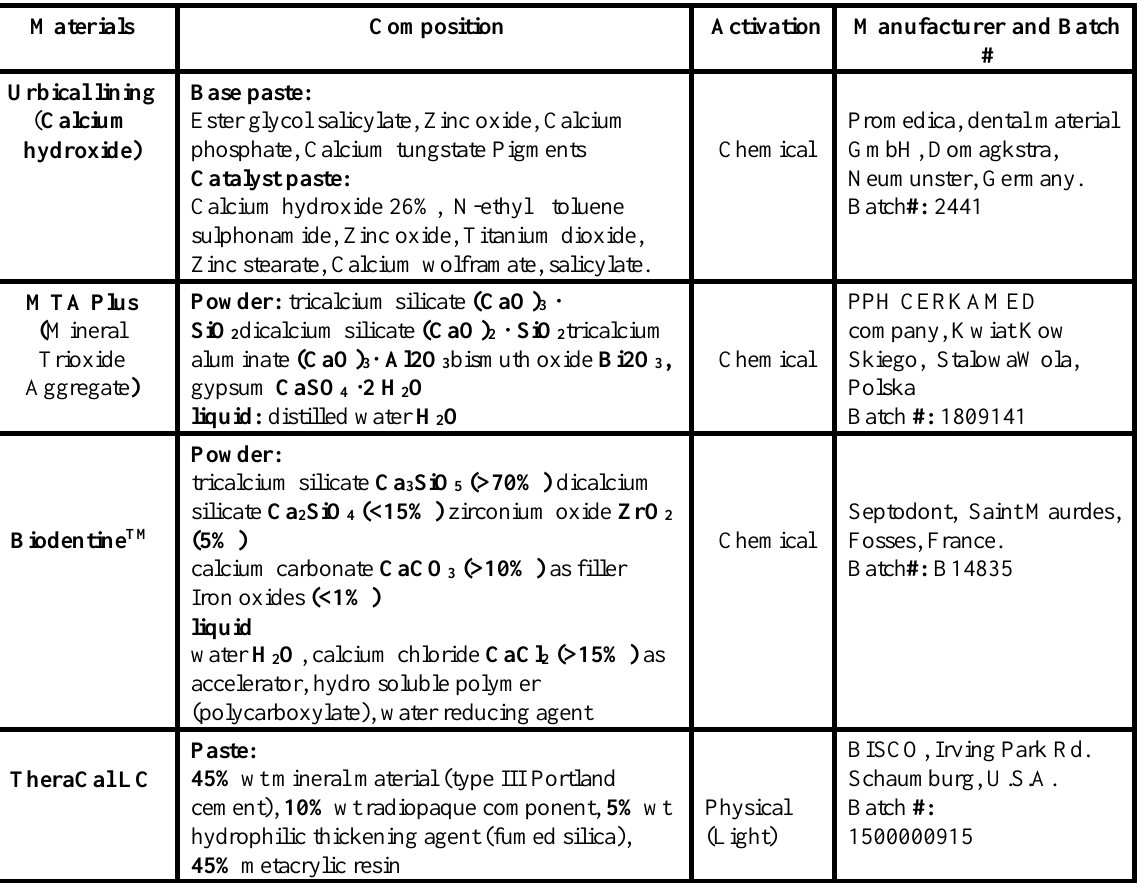
Table (1): Types of materials used in the study, types of activation, manufacturer and batch